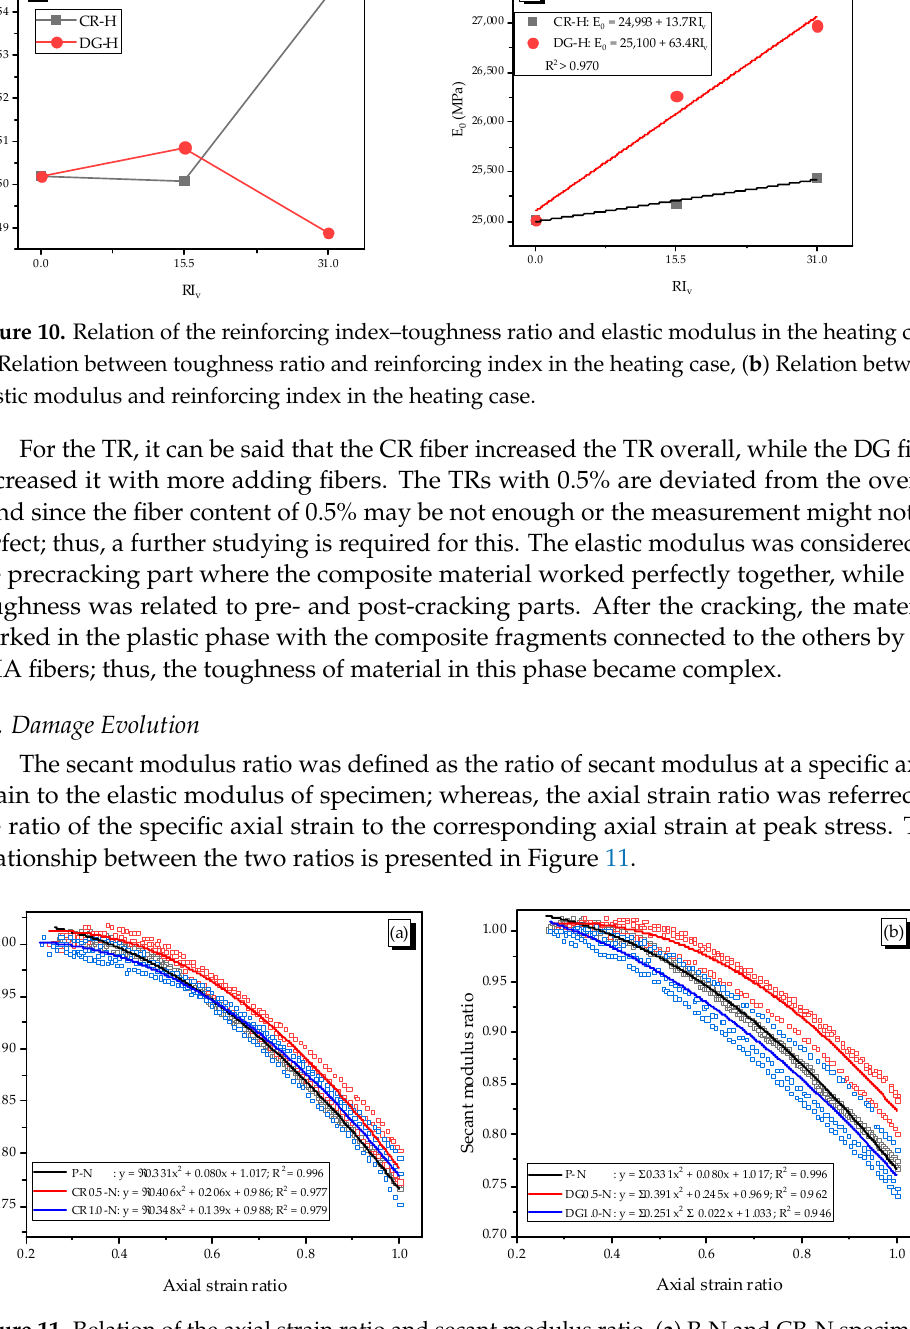
Figure 11. Relation of the axial strain ratio and secant modulus ratio, ( a ) P-N and CR-N specimens, ( b ) P-N and DG-N specimens.